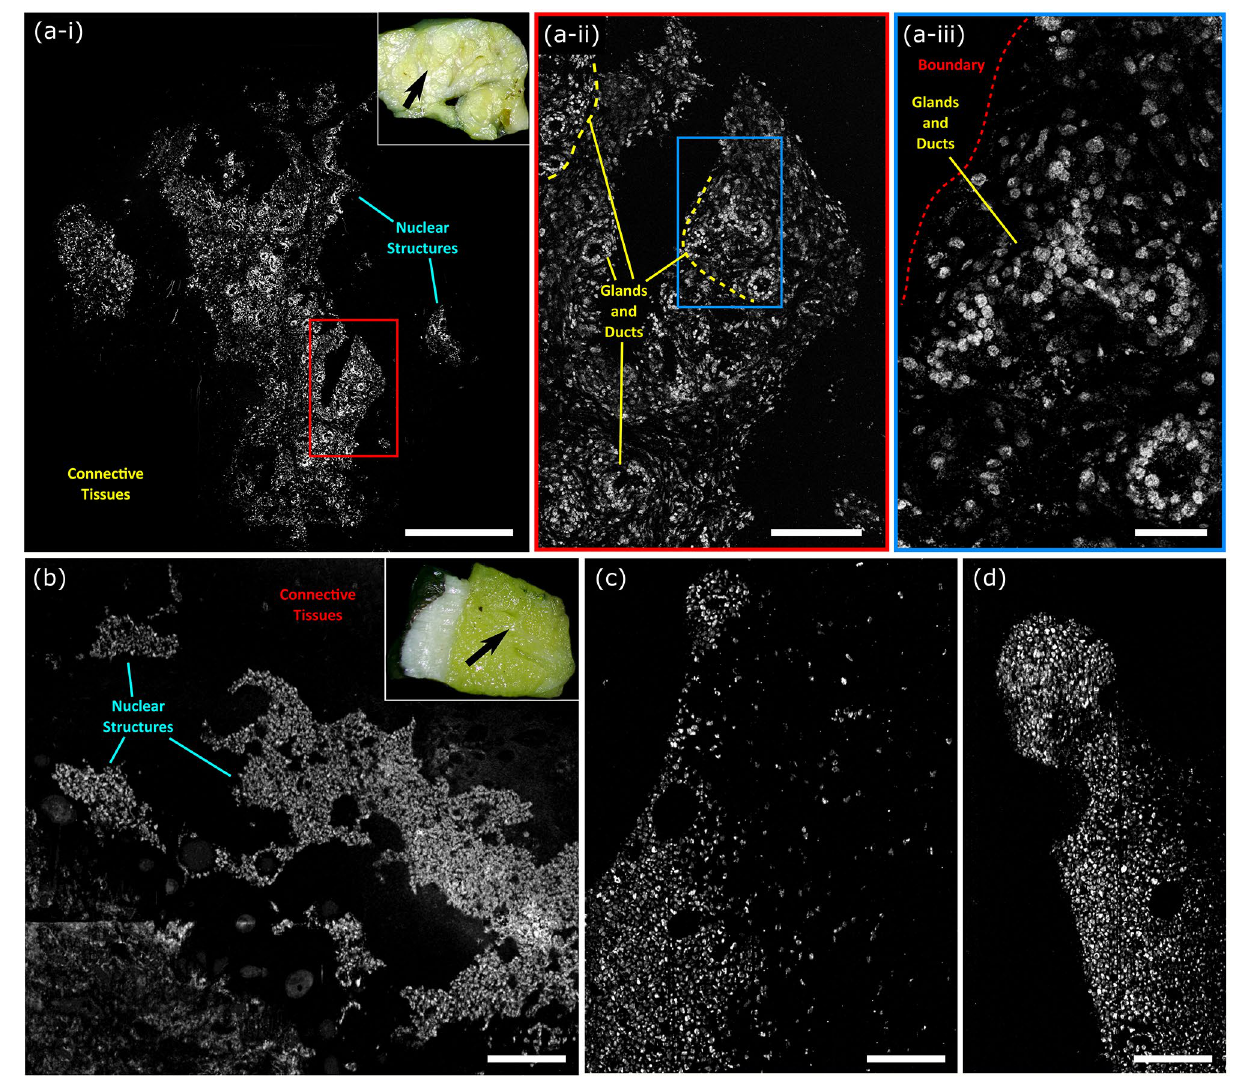
Figure 5. PARS histological imaging of nuclear morphology in unprocessed excised tumor tissues. ( a ) ( i ) Large field of view PARS image of resected Rattus mammary tumor. The inset in the upper right indicates the region of the bulk tissue section in which the PARS images were captured. Scale Bar: 1 mm. ( ii, iii ) Subsections of the large field of view image in ( i ) highlighting regions of interest within the large field images. ( ii ) Scale Bar: 500 µm. ( iii ) Scale Bar: 25 µm. ( b – d ) PARS histological imaging of nuclear morphology in unprocessed formalin fixed excised post-menopausal human breast tissues. The inset in the upper right highlights the region of the breast tissue section which the PARS images were captured in. ( b ) Scale Bar: 275 µm ( c ) Scale Bar: 150 µm ( d ) Scale Bar: 150 10.1 µm axial resolution in free space, corresponding to 7.3 µm in tissues, assuming an average refractive index of n = 1.38. Depending on the application, the system used either a 0.14 NA or 0.4 NA objective corresponding